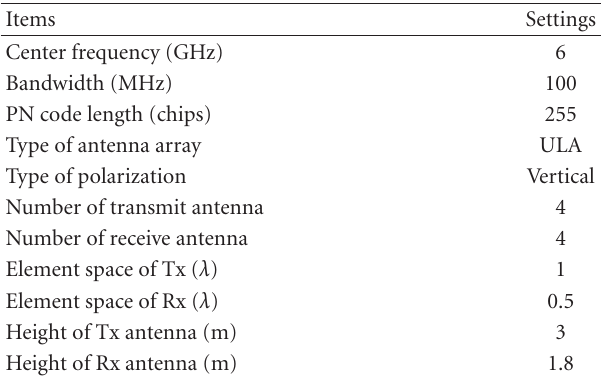
Figure 2: Indoor channel measurement layout and measurement position arrangement. Table 1: Measurement